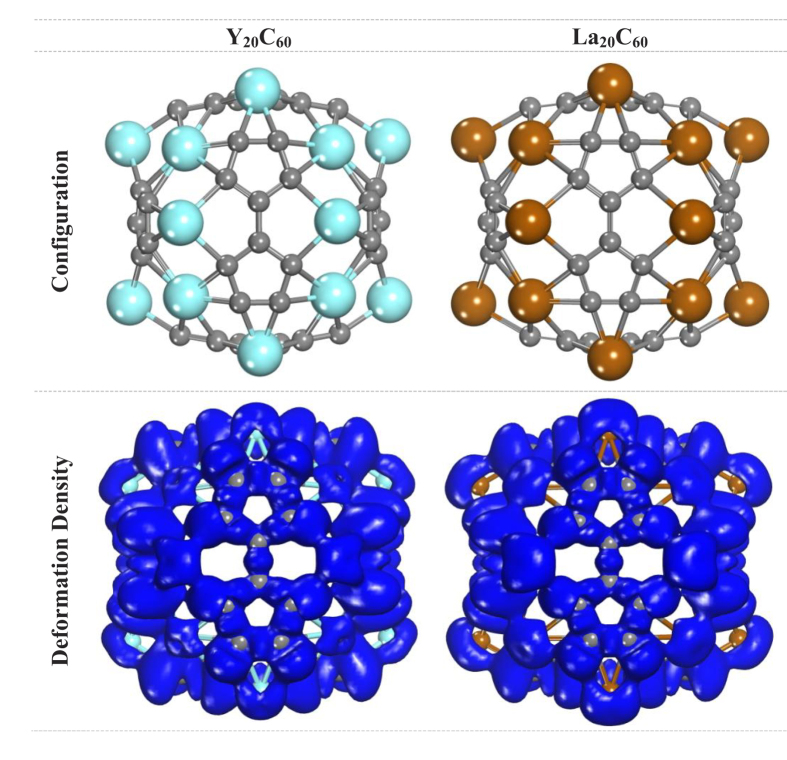
The configurations and deformation electron densities of Y20C60 and La20C60.The isosurface is taken to be 0.01 e/Å3.